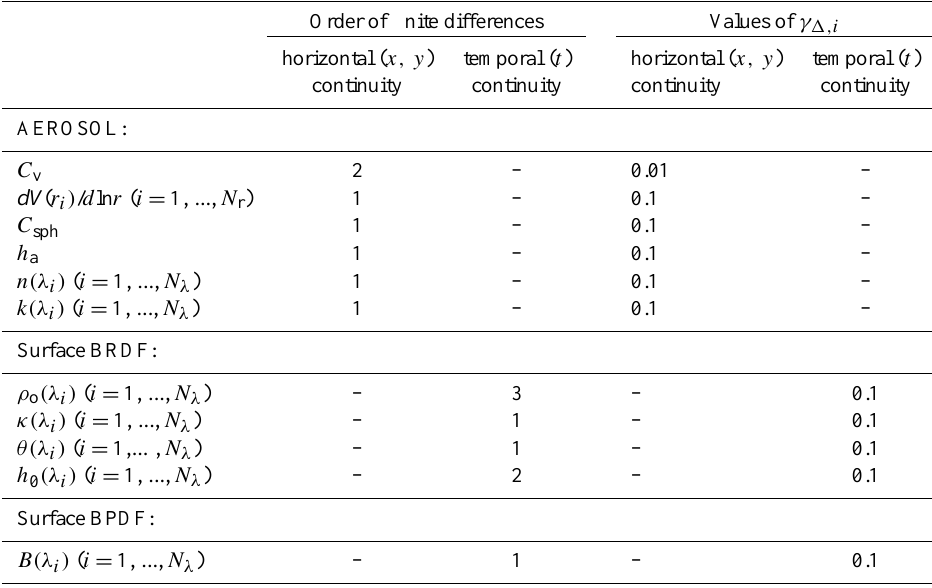
Table 4. The types of the finite differences and the correspondent values of Lagrange multipliers γ 1,i used in the algorithm for applying inter-pixel smoothness